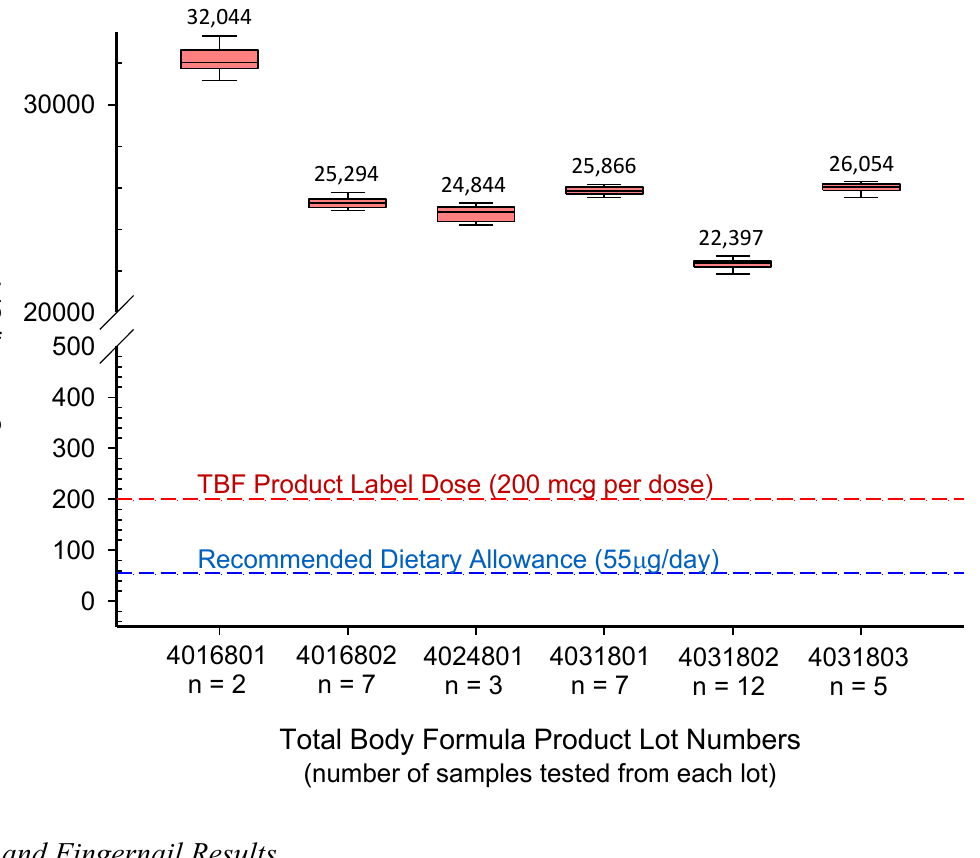
Figure 1. Se concentrations (μg/dose) in the six recalled TBF product lots. Se concentrations are given in micrograms per 1-ounce recommended dose for the 36 (of 54) samples submitted with corresponding lot numbers. The dose means (s.d.) range from 22,319 (151) to 32,184 (301) μg/dose over the 6 lots. The intended dose for all six lots was 200 μg/dose. Each box plot indexes the 10th, 25th, 50th (median), 75th, and 90th percentiles. An additional 16 samples without lot numbers, but obviously distributed among the 6 recalled lots, and 2 samples from TBF lots produced prior to September 2007, were also submitted and analyzed. Results for all 54 samples are summarized in Table